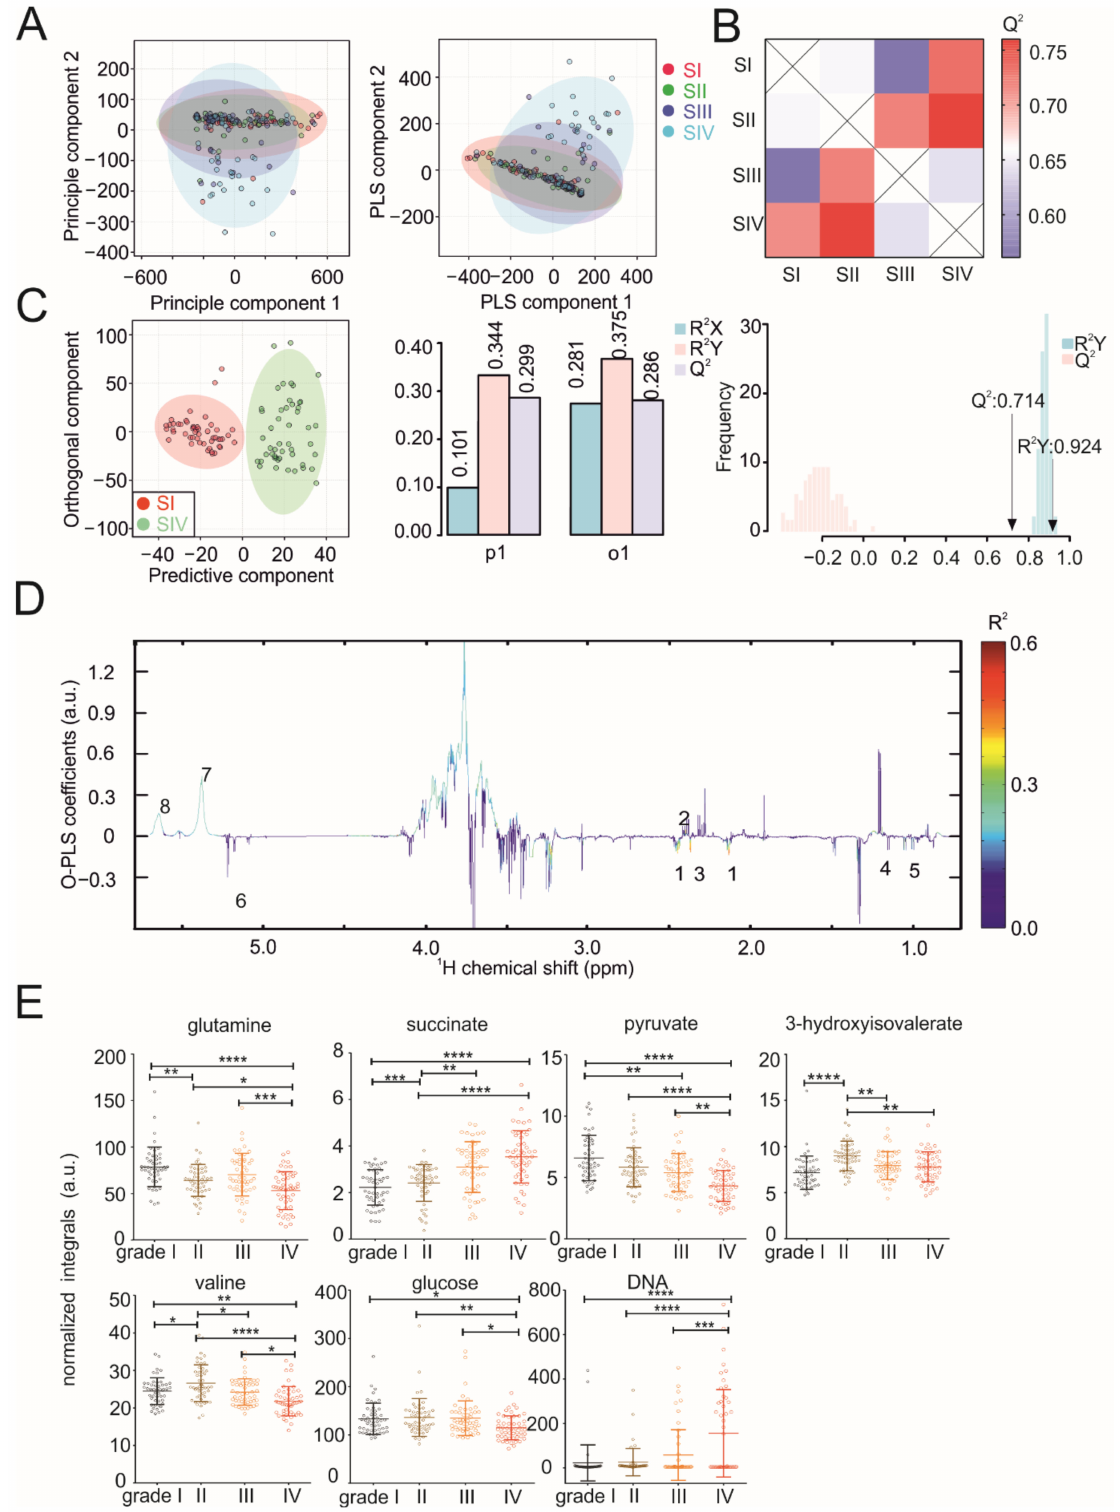
Figure 2. NMR metabolomics analysis of serum samples. ( A ) PCA and PLS-DA plots of serum samples. ( B ) Heatmap showing O-PLS-DA-derived Q 2 for pairwise comparisons of the serum samples. ( C ) O-PLS-DA plot of the serum samples, including a cross-validation. ( D ) The reduced NMR spectrum reveals altered components in normalized serum samples. Positive covariance corresponds to the components present at increased concentrations, whereas negative covariance corresponds to decreased component concentrations. The predictivity of the model is represented by R 2 . (1) glutamine, (2) succinate, (3) pyruvate, (4) 3-hydroxyisovalerate, (5) valine, (6) glucose and (7) and (8) DNA. ( E ) Statistical analysis